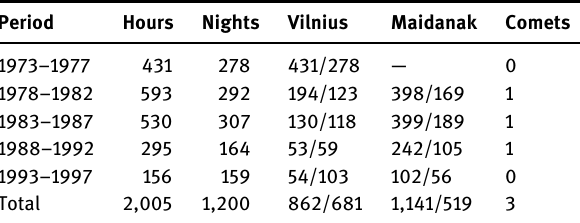
Table 1: The number of nights and hours conducted in two obser - vational sites